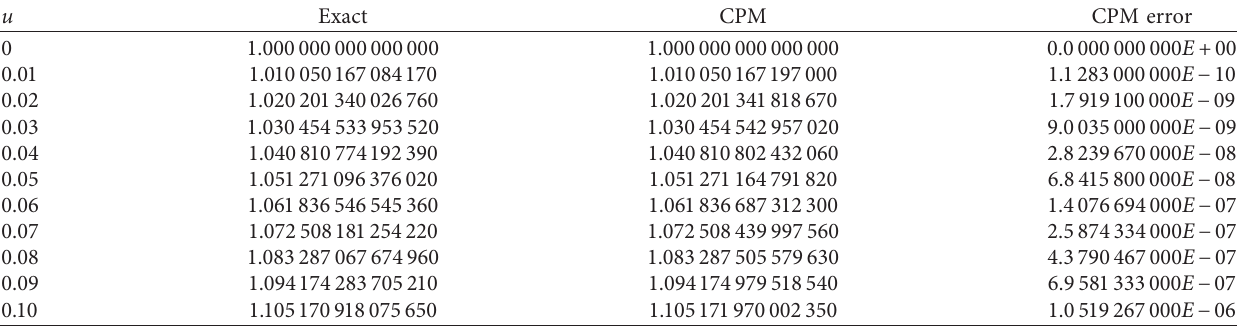
Table 1: Exact, CPM solution, and CPM A.E of problem 1 for m � 4.